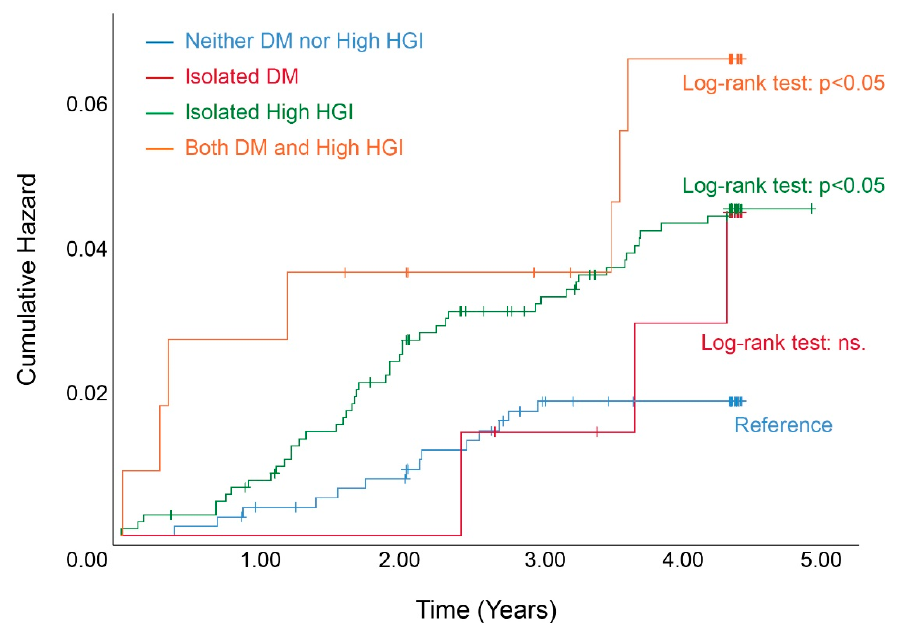
Figure 3. Kaplan–Meier curves for cumulative hazard of incident stroke events stratified by DM-HGI system. Kaplan–Meier curves exhibited the tendency of cumulative hazard, and we further compared different DM-HGI statuses using the log-rank test. Compared with the subjects who had neither DM nor high HGI (blue curve), isolated DM patients did not present a higher incident stroke risk (red curve). However, two high-HGI subgroups both had higher cumulative hazards of stroke than reference. Especially, the isolated high-HGI subgroup presented an elevated risk of stroke, although the subgroup population did not suffer from DM (green curve). Moreover, the patients with both DM and high HGI had the highest hazard of stroke (orange curve). Abbreviations: HGI, glycated hemoglobin index; DM, diabetes mellitus. Statistical significance was defined as p < 0.05 under two-tailed condition.